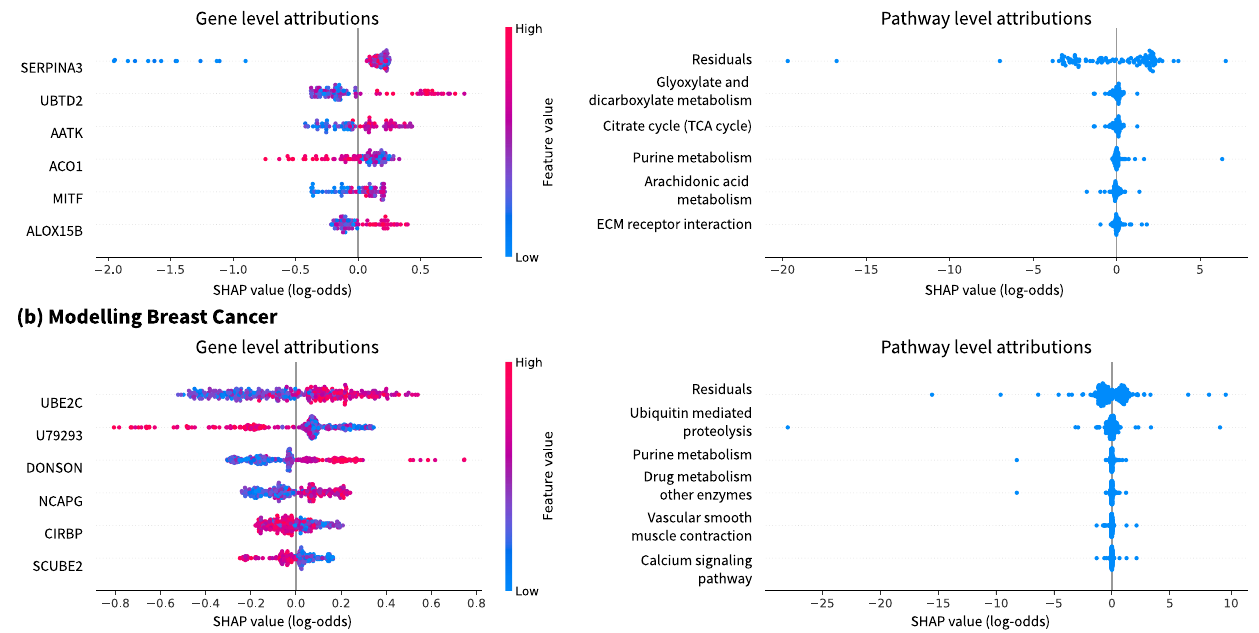
Fig. 4 Propagating attributions to gene sets enables higher-level understanding. a Gene and gene set attributions for predicting Alzheimer's disease using gene expression data. b Gene and gene set attributions for predicting breast cancer tumor stage using gene expression data. Residuals in the gene set attributions summarize contributions for genes that are not present in any gene set and describes variations in output not described by the pathways we analyzed. Note that ( a ) and ( b ) show summary plots (Supplementary Methods Section